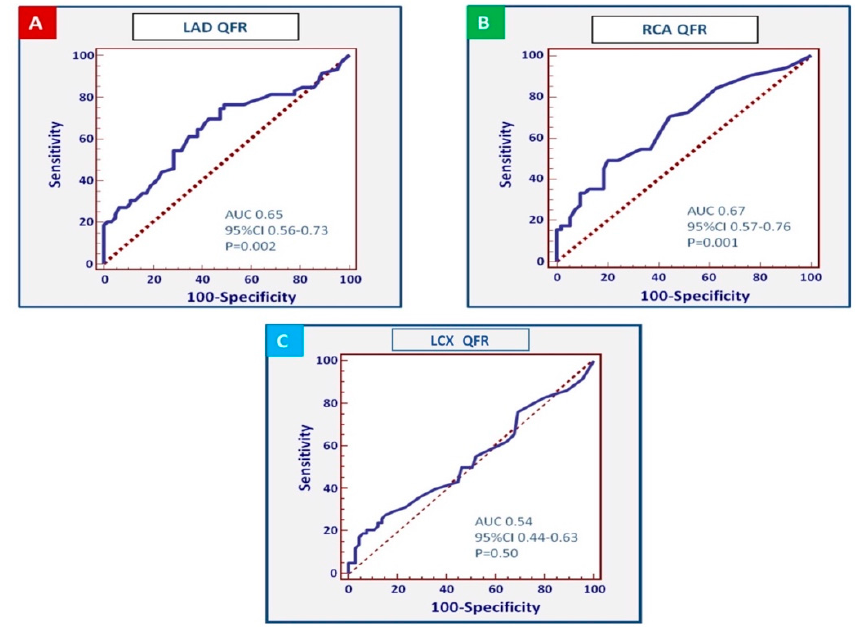
Figure 4. ROC (receiver operating characteristic) curves of LAD QFR ( A ), RCA QFR ( B ), and LCX QFR ( C ). AUC: area under the curve.